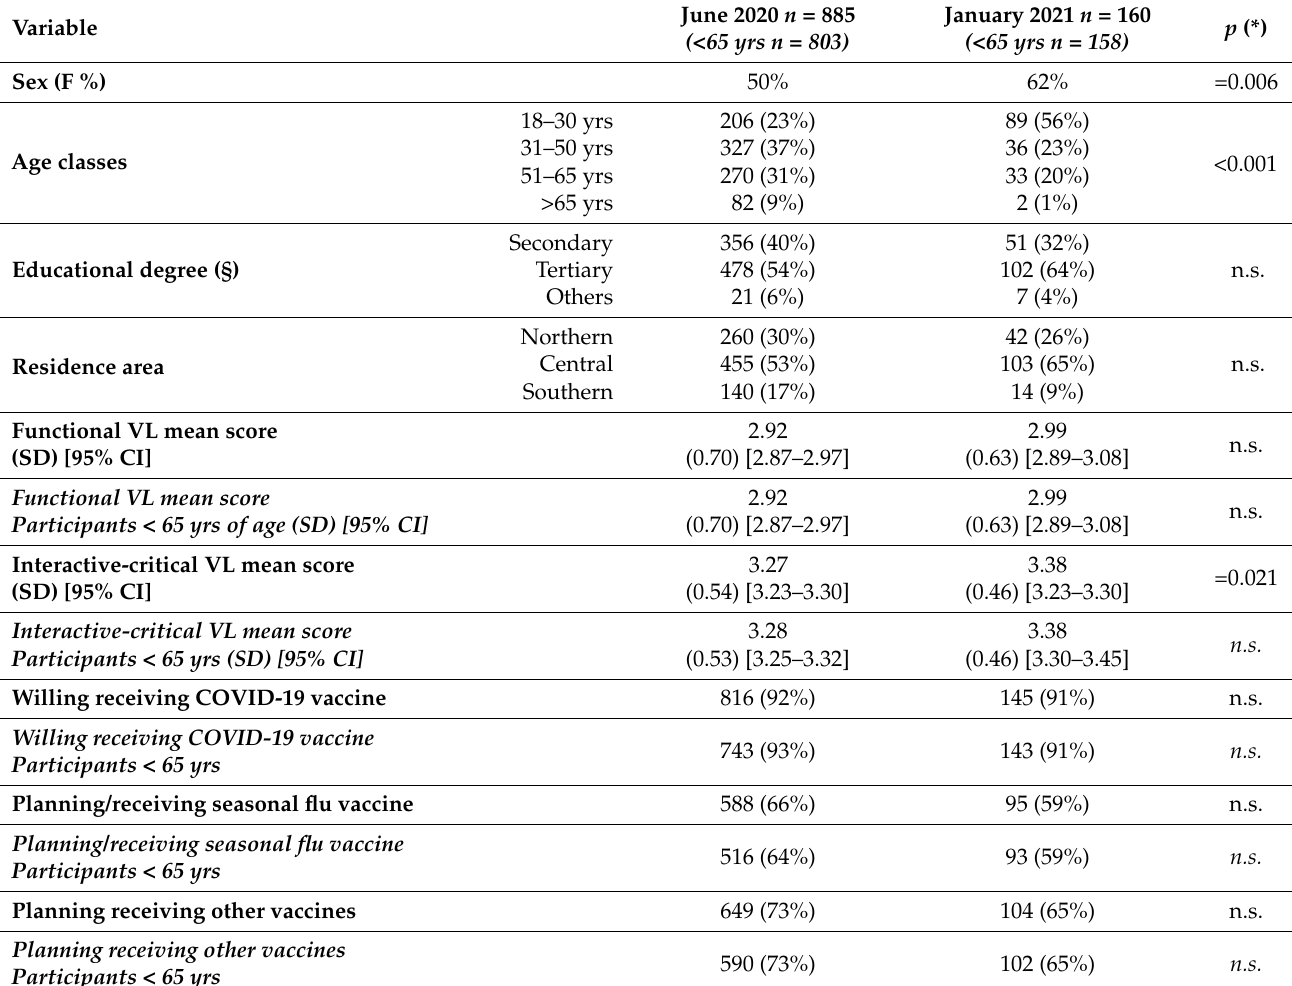
Table 3. Main demographics, vaccine literacy (VL) scores and attitudes toward vaccinations in the total populations and in participants aged < 65 years. Findings from the June 2020 and January 2021 surveys and level of